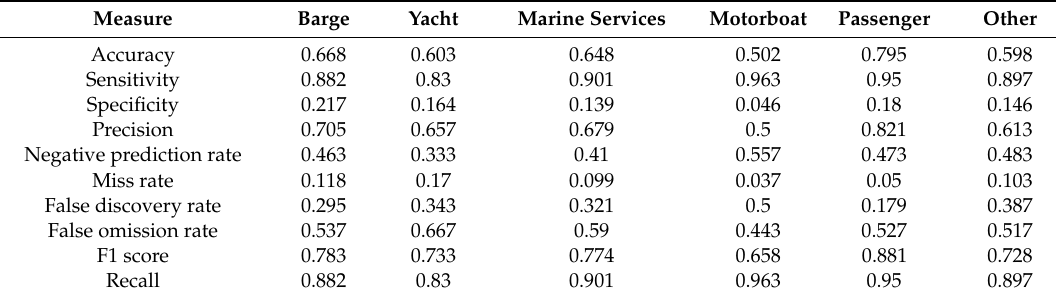
Table 4. Mean quality measures for the trained classifier.